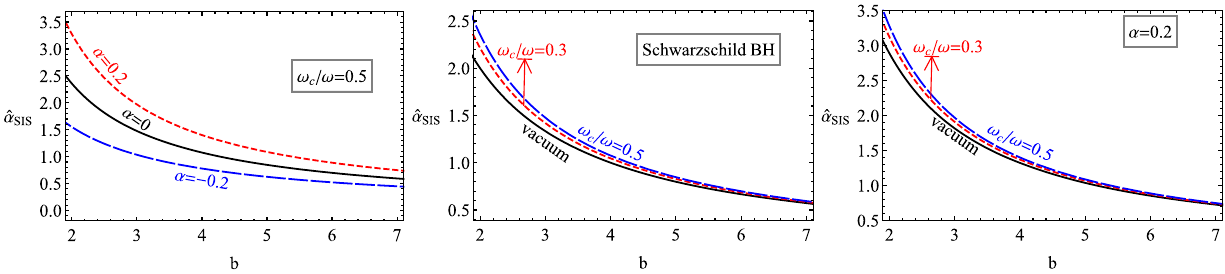
Fig. 2 Deflection angle ˆ α b as a function of the impact parameter b for MOG compact object surrounded SIS plasma. In the left panel we have fixed the plasma frequency as ω c /ω = 0 . 5, the middle one cor-